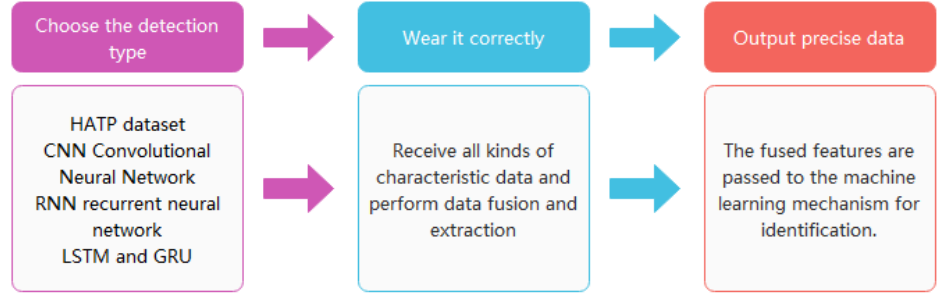
Figure 3. Model diagram of the working process of the wearable